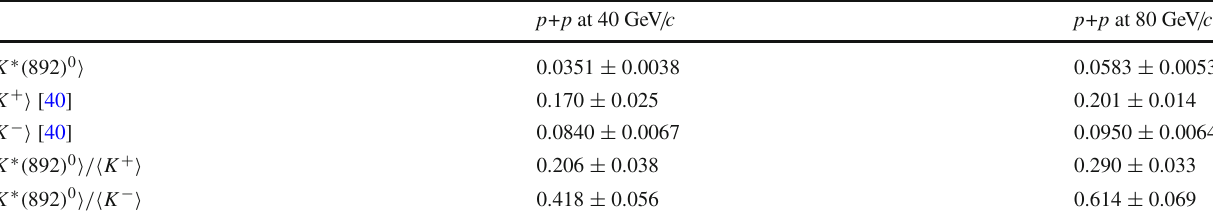
Table10 Themeanmultiplicitiesof K ∗ ( 892 ) 0 , K + and K − ,aswellas (cid:8) K ∗ ( 892 ) 0 (cid:9) / (cid:8) K + (cid:9) and (cid:8) K ∗ ( 892 ) 0 (cid:9) / (cid:8) K − (cid:9) , measured in inelastic p+p interactions at p beam = 40 and 80 GeV / c by the NA61/SHINE exper-